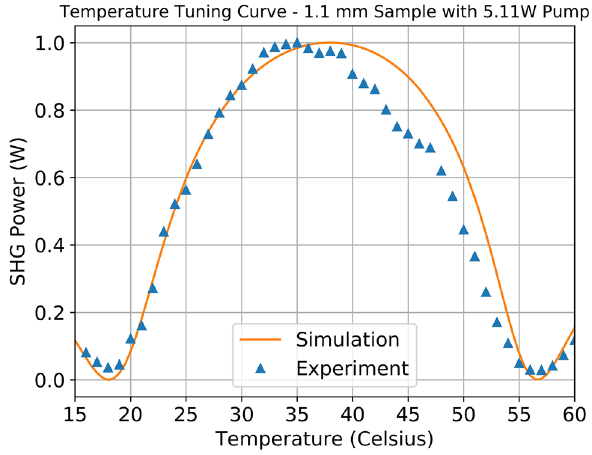
Figure 5. Normalized temperature tuning curve at 5 W 808 nm pump power vs. simulated temperature tuning curve using the intracavity theory.